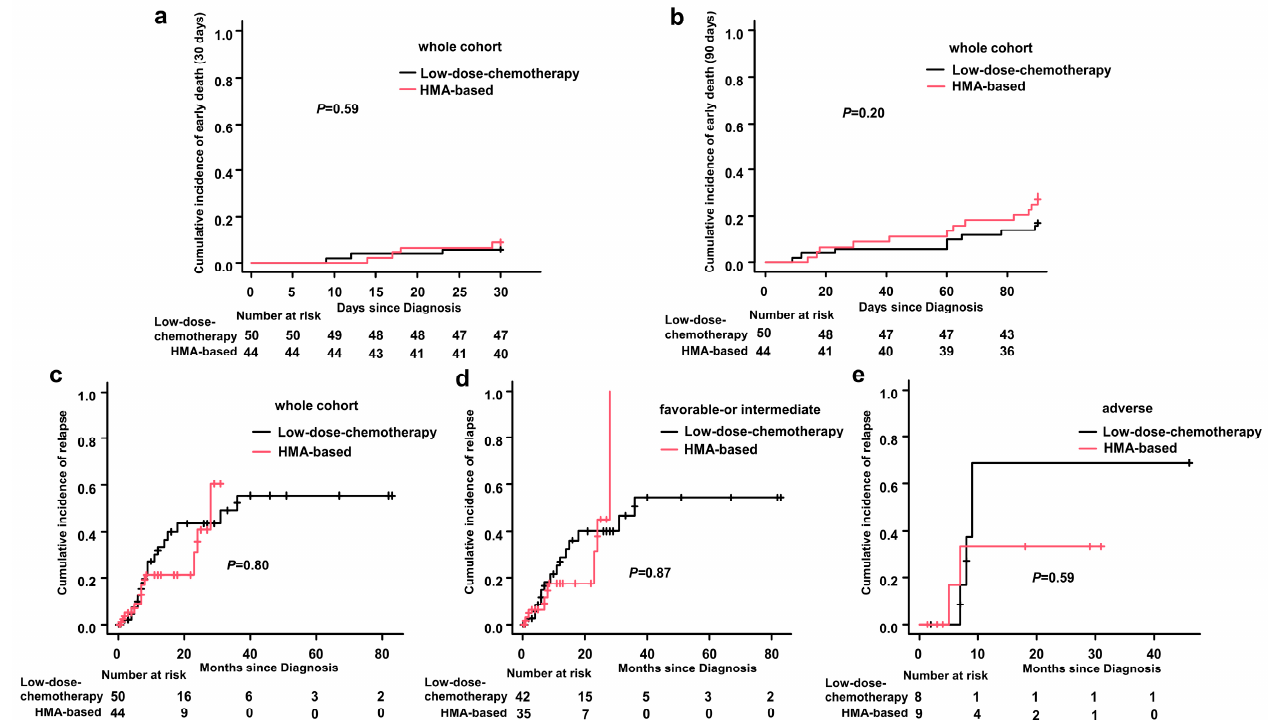
Figure 2. Early death and relapse: ( a ) early death in the first 30 days for the whole cohort; ( b ) early death in the first 90 days for the whole cohort; ( c ) relapse for the whole cohort; ( d ) relapse for favorable- or intermediate-risk patients; and ( e ) relapse for adverse-risk patients. Abbreviations: HMA-based, hypomethylating agents combined with low dose chemotherapy.